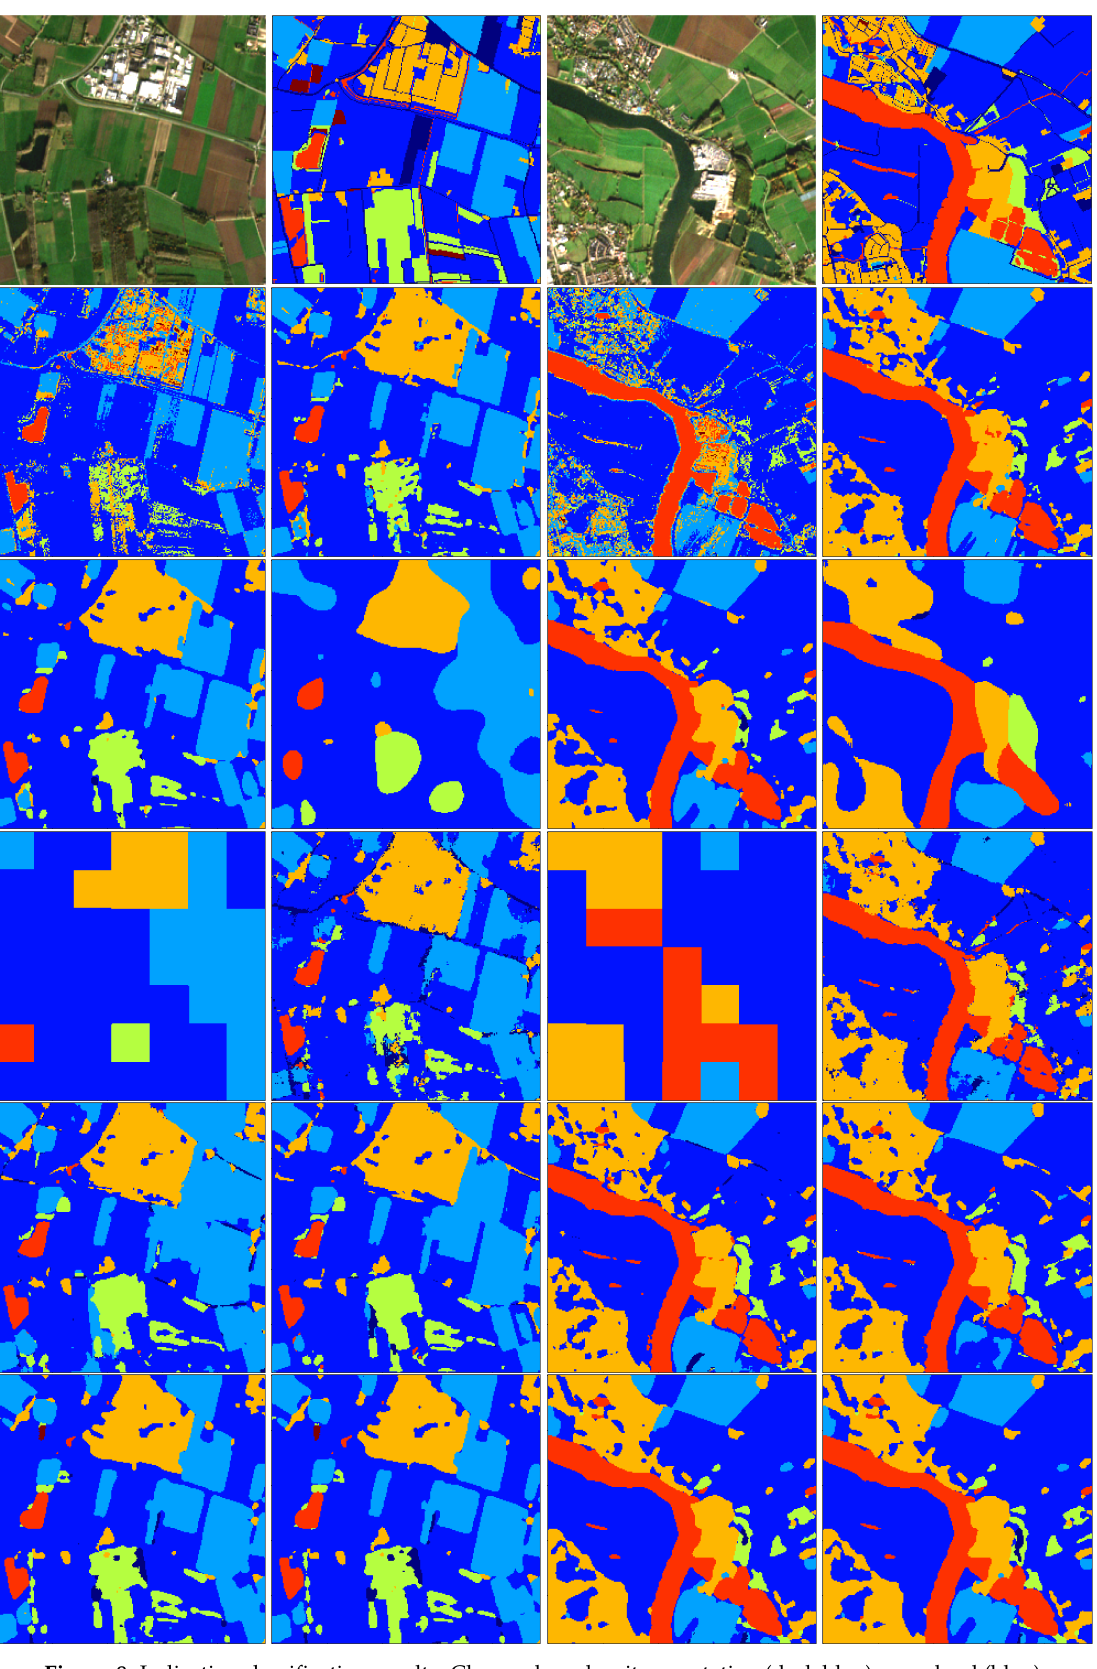
Figure 8. Indicative classification results. Classes: low-density vegetation (dark blue), grassland (blue), cropland (light blue), built-up (blue-green), forest (green), other (orange), water (red), and remaining classes